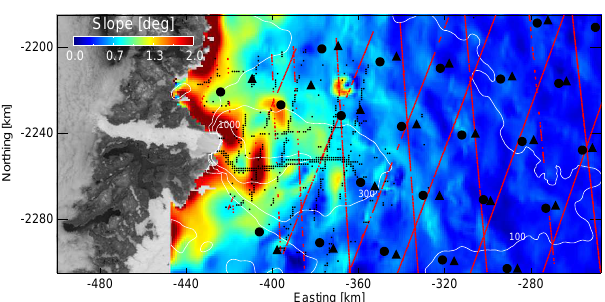
Fig. 1. Slope from Bamber et al. (2001), plotted over a MODIS image from June 2002. Also uncorrected (large black dots) and corrected (black triangles) locations of Envisat cross-over clusters, ICESat tracks (red dots), and ATM flight lines (small black dots) are shown. Velocity is shown as 100, 300, and 1000myr − 1